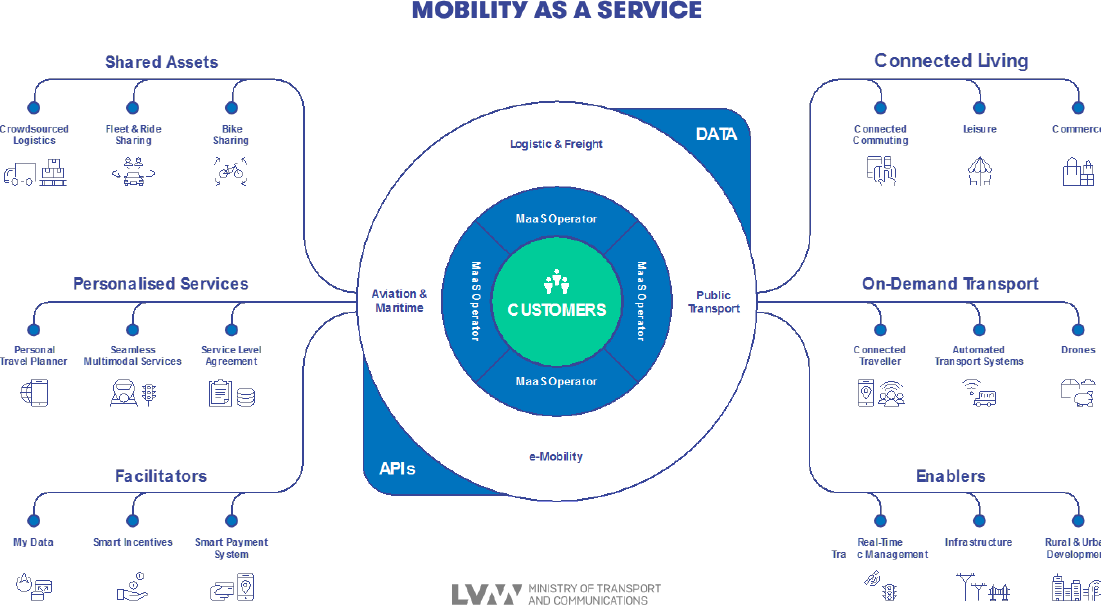
Figure 1: Mobility as a Service